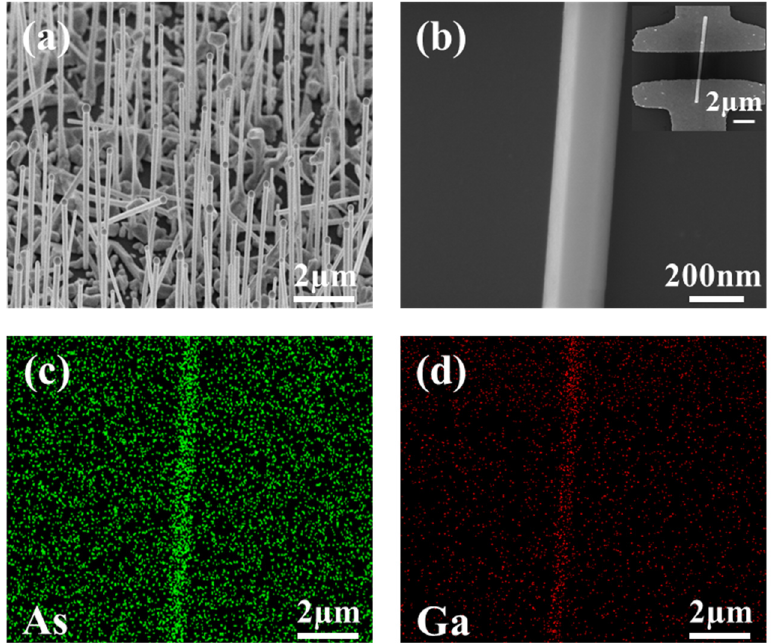
Figure 1. ( a ) SEM images of a GaAs nanowire array ( a ) and single GaAs nanowire ( b ). The illustration in the upper right corner is SEM diagram of GaAs nanowire photodetectors. ( c , d ) Energy dispersive X-ray spectroscopy (EDX) of the single GaAs nanowire.